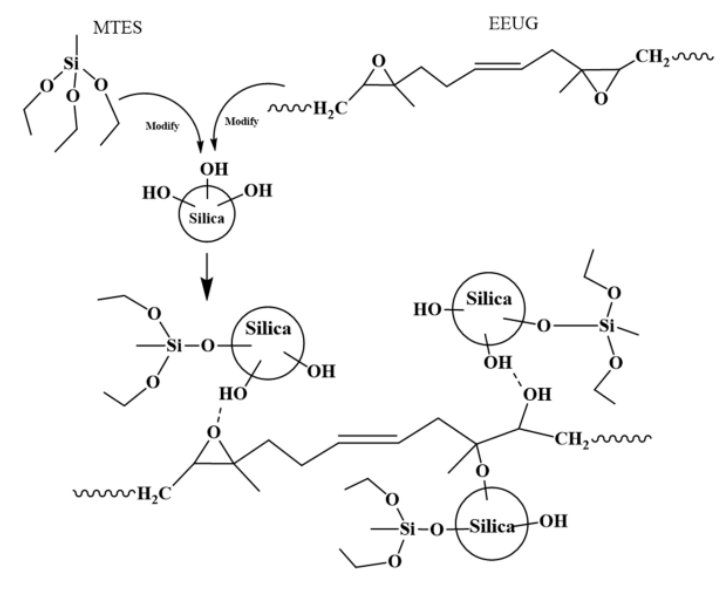
Figure 1. Schematic diagram of the synergistic effect of methyltriethoxysilane (MTES) and epoxidized eucommia ulmoides gum (EEUG) on silica.